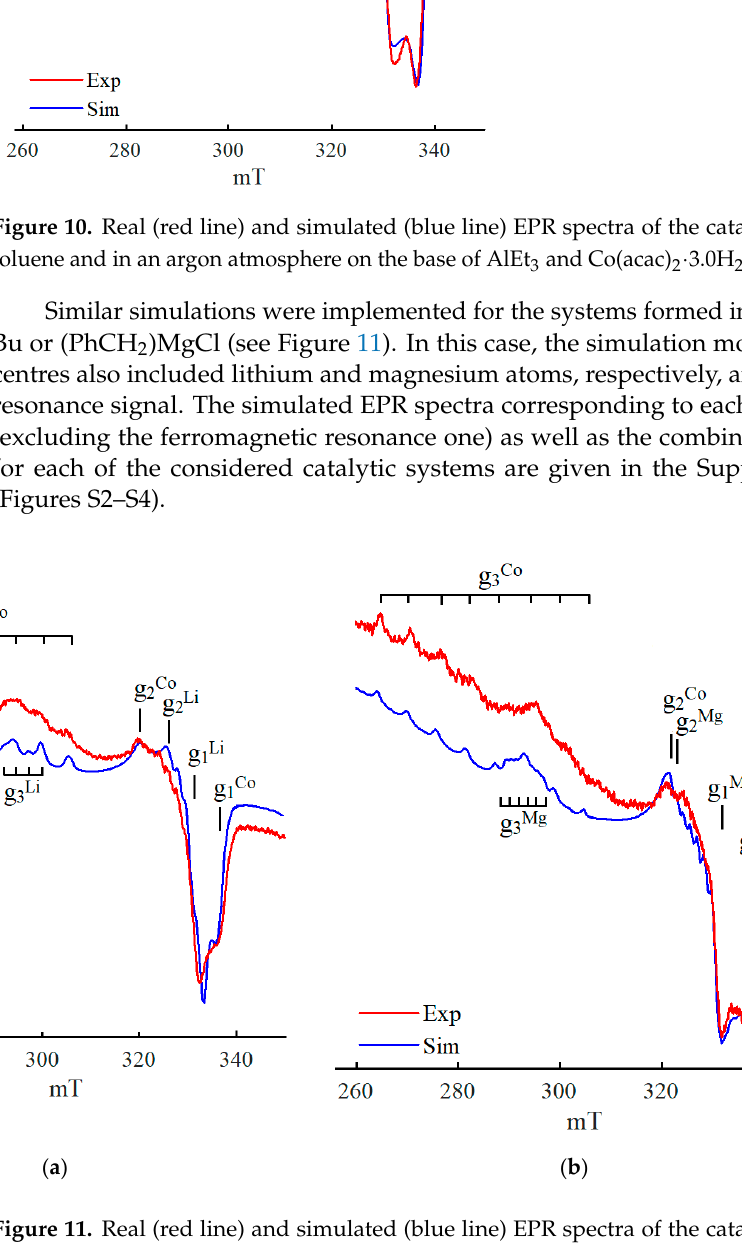
Figure 11. Real (red line) and simulated (blue line) EPR spectra of the catalytic system formed in toluene and in an argon atmosphere on the base of Co(acac) 2 and ( a ) Li- n -Bu or ( b ) PhCH 2 )MgCl, recorded at T = 77